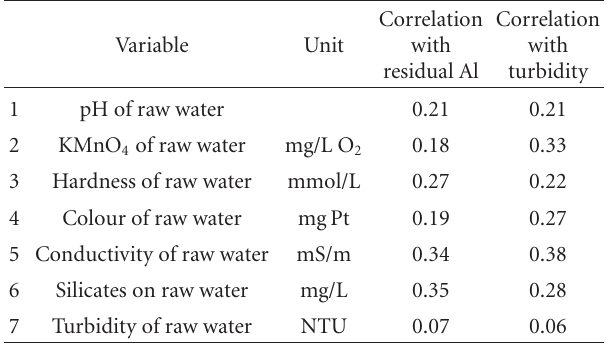
Correlation Correlation with with residual Al